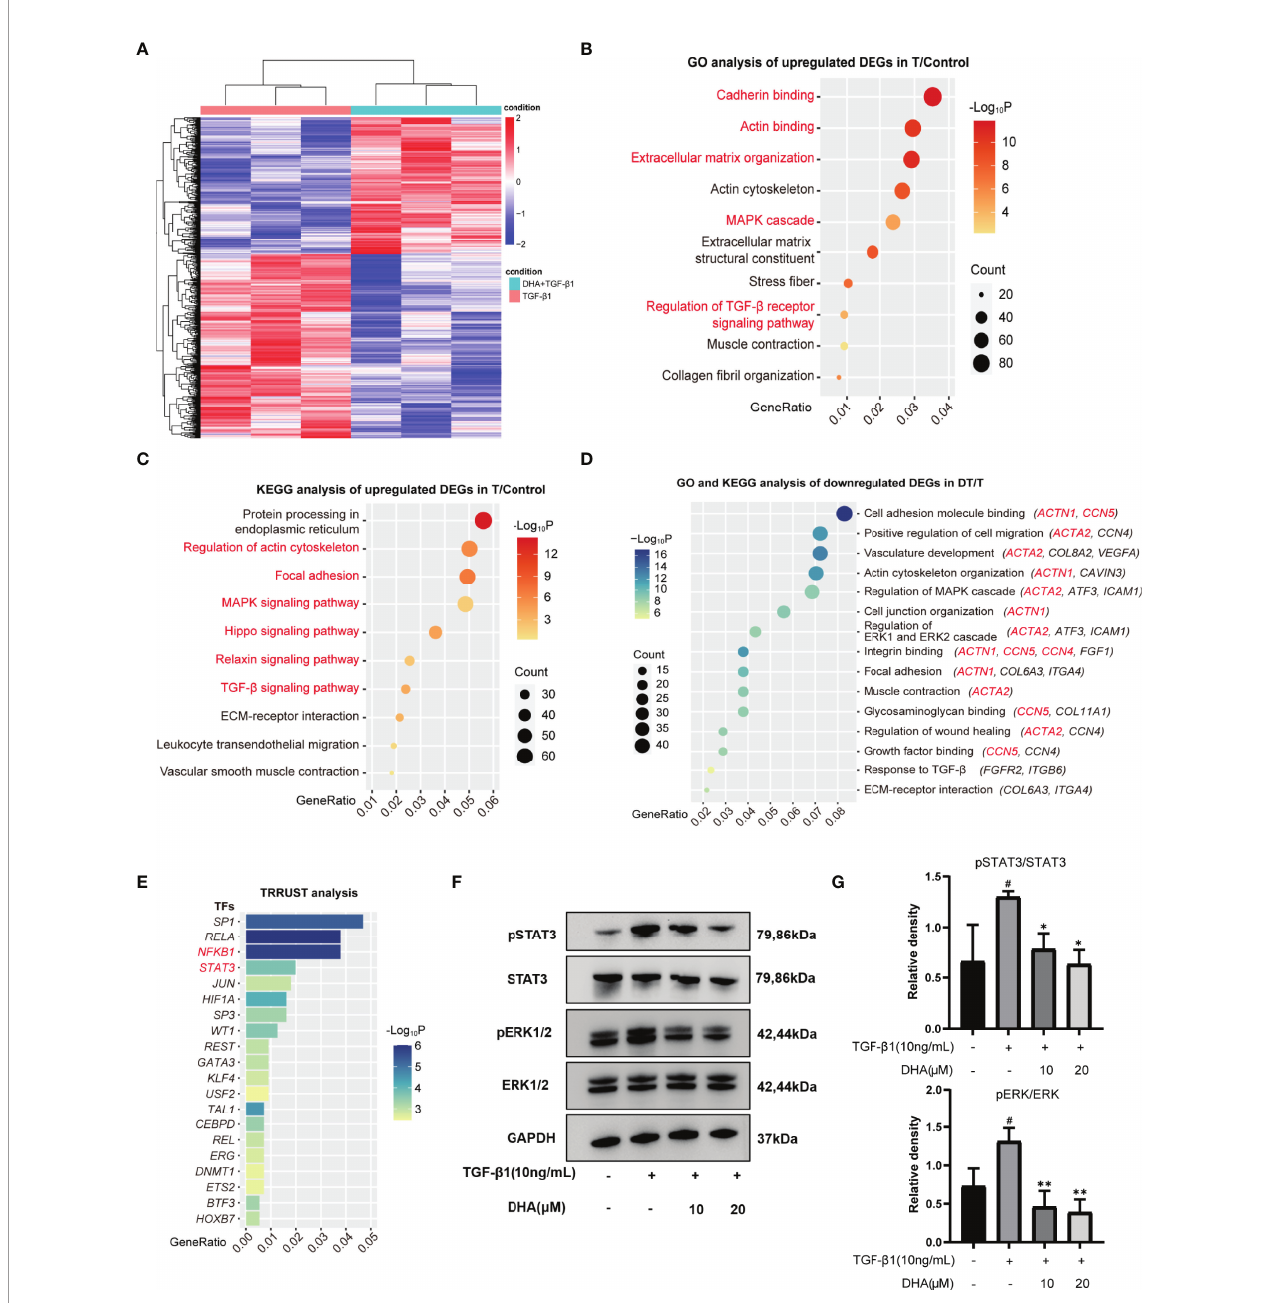
FIGURE 4 | DHA suppresses TGF- b 1-induced phosphorylation levels of ERK1/2 and STAT3. (A) Differentially expressed genes (DEGs) were explored and presented in heatmap of mRNA abundance. Columns denoting GO OFs grouped by TGF- b 1(10 ng/mL, 48 h) stimulation with or without a 3-h pretreatment of DHA (20 m M)were sorted bydiversity within theTGF- b 1 group (n=3) andthe TGF- b 1+DHA group (n=3); Rows denoting RNA expression according to their enrichment in TGF- b 1 versusTGF- b 1+DHA. (B, C) Bubblechart from GO analysis or KEGG analysis showed TGF- b 1-stimulatedgenes were mainly associated with celldifferentiation, migration,and extracellular matrix organization. (D) Bubble chart from GO-KEGG analysis showed DHA signi fi cantlydownregulates fi brosis-associatedprocesses. The MAPK signalingand ERK1/2signalingweredecreased inTGF- b 1+DHA group. (E) The top 20 transcription factorsdifferentially regulated byDHA treatment were analyzed byTRRUST. (F) The protein levels of p-ERK, ERK,p-STAT3, STAT3, GAPDH in GO OFsstimulated with TGF- b 1 (10 ng/mL,3 h)with or withouta 3-h pretreatment with DHA (10, 20 m M)were determinedusing westernblot analysis(n = 3). (G) The protein levelsofp-ERKand p-STAT3 were quanti fi ed andanalyzed. # P < 0.05 comparedwith the control;*P < 0.05, **P < 0.01 compared with TGF- b 1